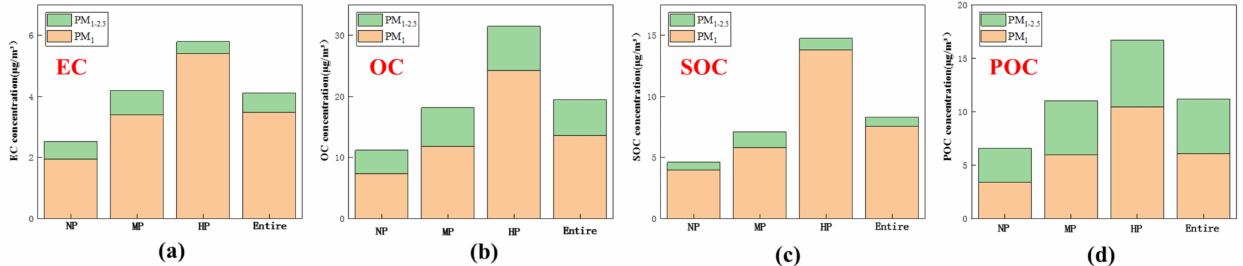
Figure 4. Concentrations of elemental carbon ( a ), organic carbon ( b ), secondary organic carbon ( c ), primary organic carbon ( d ) in PM 1 and PM 1–2.5 on non-pollution, mild-moderate pollution and heavy pollution in Handan in the period from